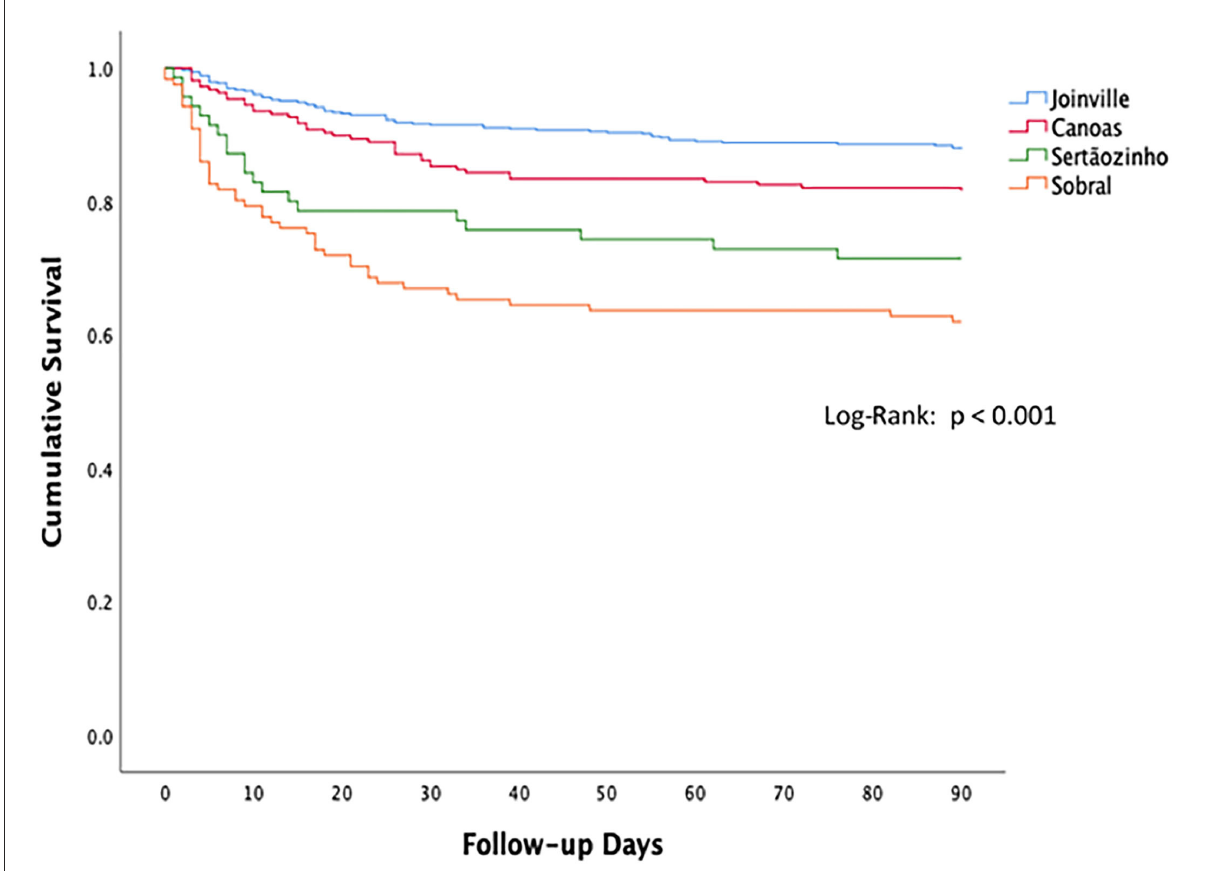
FIGURE3 Kaplan–Meier curve showing 90-day cumulative survival after stroke in four Brazilian